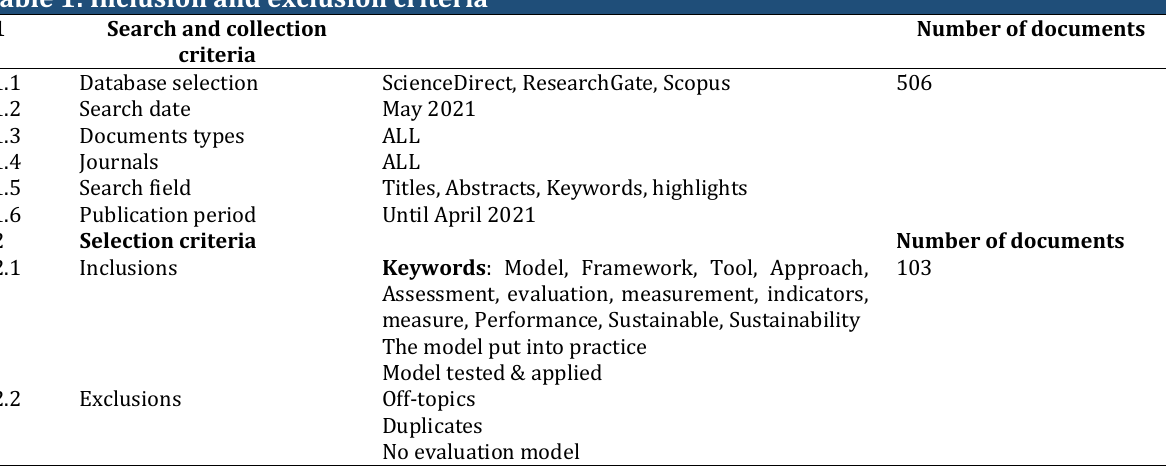
Table 1: Inclusion and exclusion